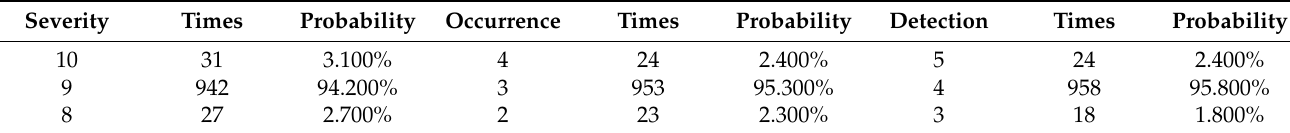
Table 7. Case 2: Probability and times of S, O, and D .